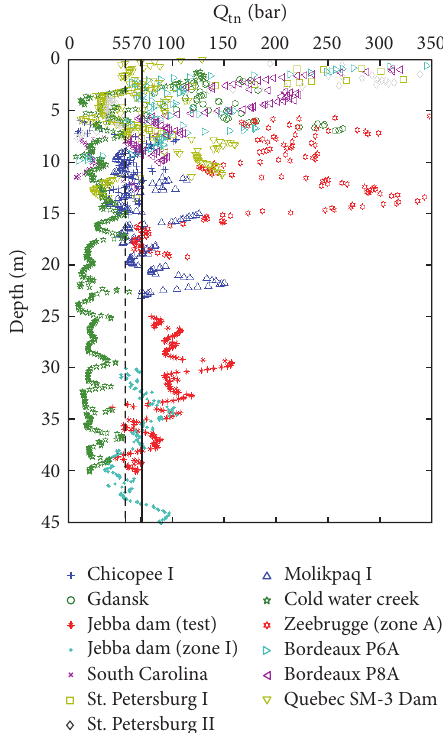
Figure 12: Initial status of target deposits based on 𝑄